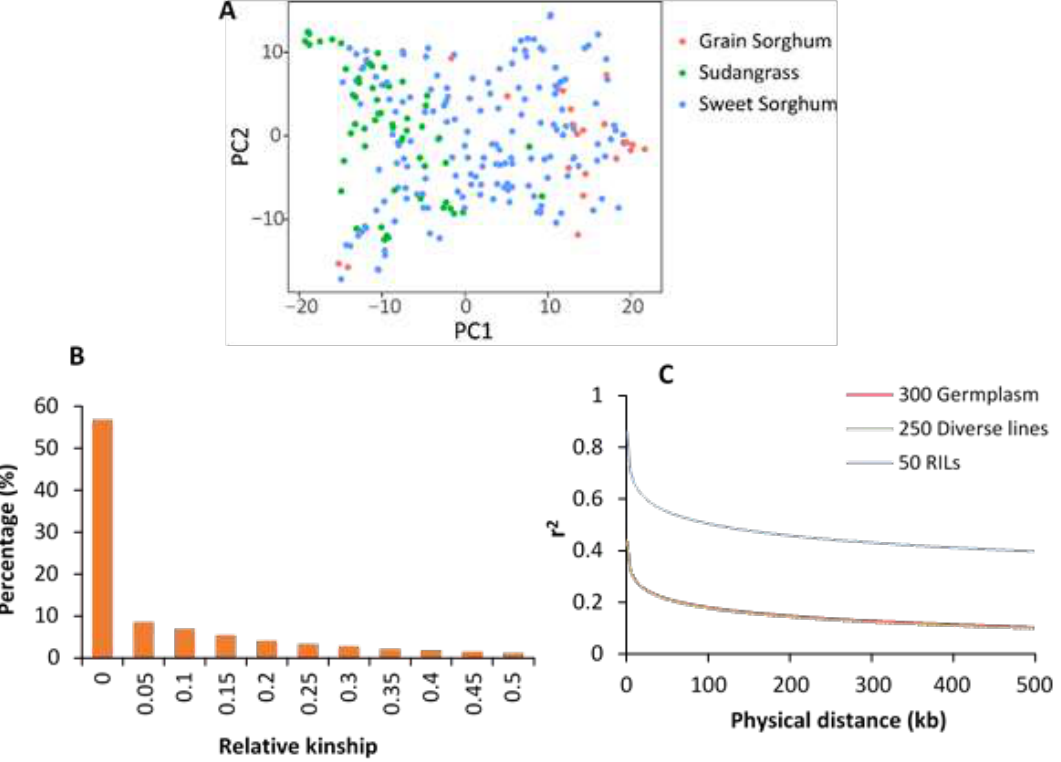
Figure 2. Principal component analysis (PCA) of 250 diverse accessions ( A ). PC1, the first principal component; PC2, the second principal component. Distribution of pairwise relative kinship estimates in the population panel ( B ). The peak around zero indicates no relationship. Genome-wide linkage disequilibrium (LD) decay ( C ). The generated r 2 value averaged with each 50 kb was plotted against the physical distance among each pair of significant single nucleotide polymorphisms (SNPs). LD decay was calculated using all 300 samples (red), 250 diverse lines (green), and 50 recombinant inbred lines (RILs) (blue).